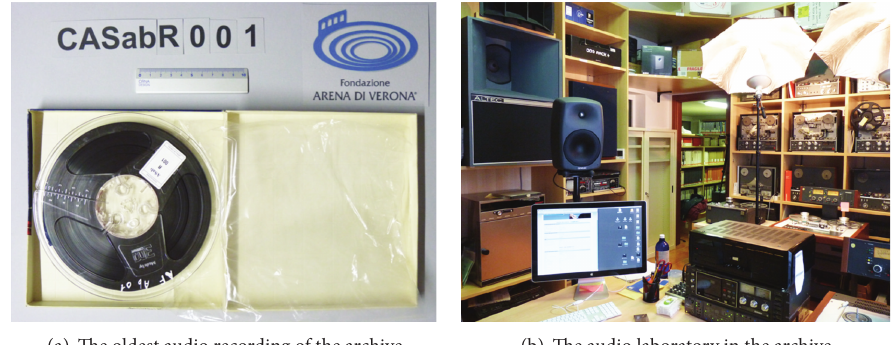
Figure 1: (a) The oldest recording in the historical section of the Arena archive, dated July 30, 1968. It is a performance of the “Trovatore” by Giuseppe Verdi, featuring Leyla Gencer as Leonora and Carlo Bergonzi as Manrico. On the box and on the reel, the label with the document signature can be seen: the progressive number is one. (b) A view of the audio laboratory setup during the REVIVAL project inside the Arena archive. Several tape recorders can be seen (two Compact Cassette players on the desk and a Studer A-812 behind them) and the A/D-D/A device (under the Compact Cassette players on the desk). On the shelves in the background, some reel-to-reel recorders can be seen. Always in the background, a storage room is visible through the open door, while on the left side is the precision incubator for thermal treatment of magnetic tapes.